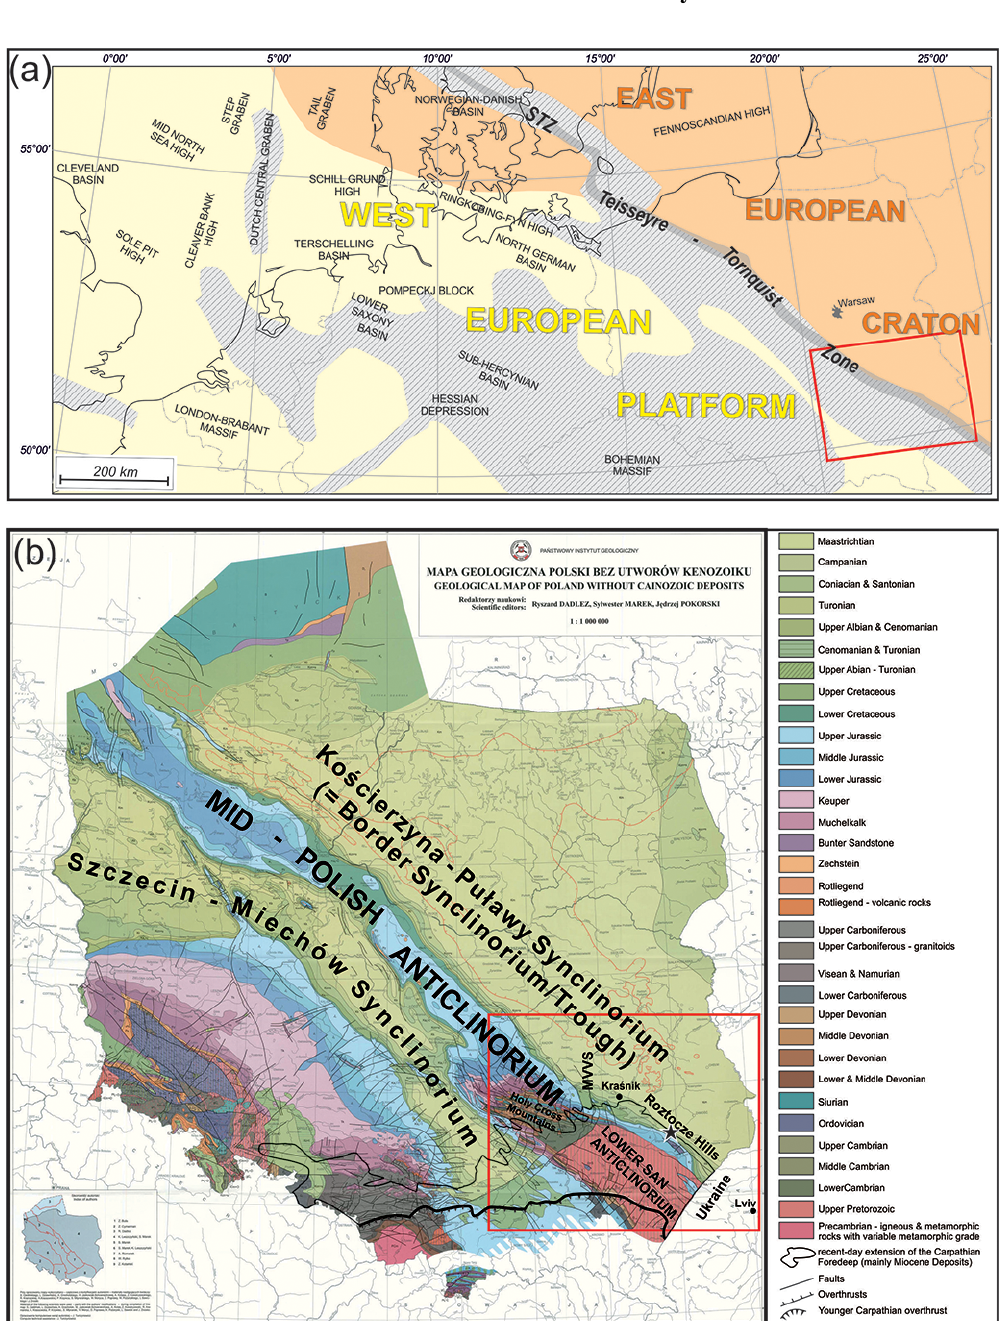
Figure 1. (a) Regional schematic map of western and central Europe (after Krzywiec et al., 2018, with further references) with the schematic extent of the Late Cretaceous–Paleocene inversion (patterned area); red rectangle – area shown in (b) and in Fig. 2; (b) general position of the Roztocze Hills and San Anticlinorium in the geological map of Poland excluding Cenozoic deposits, adopted from Dadlez et al. (2000) – except for the recent-day extension of the Carpathian Foredeep; MVVS: Middle Vistula Valley Section.